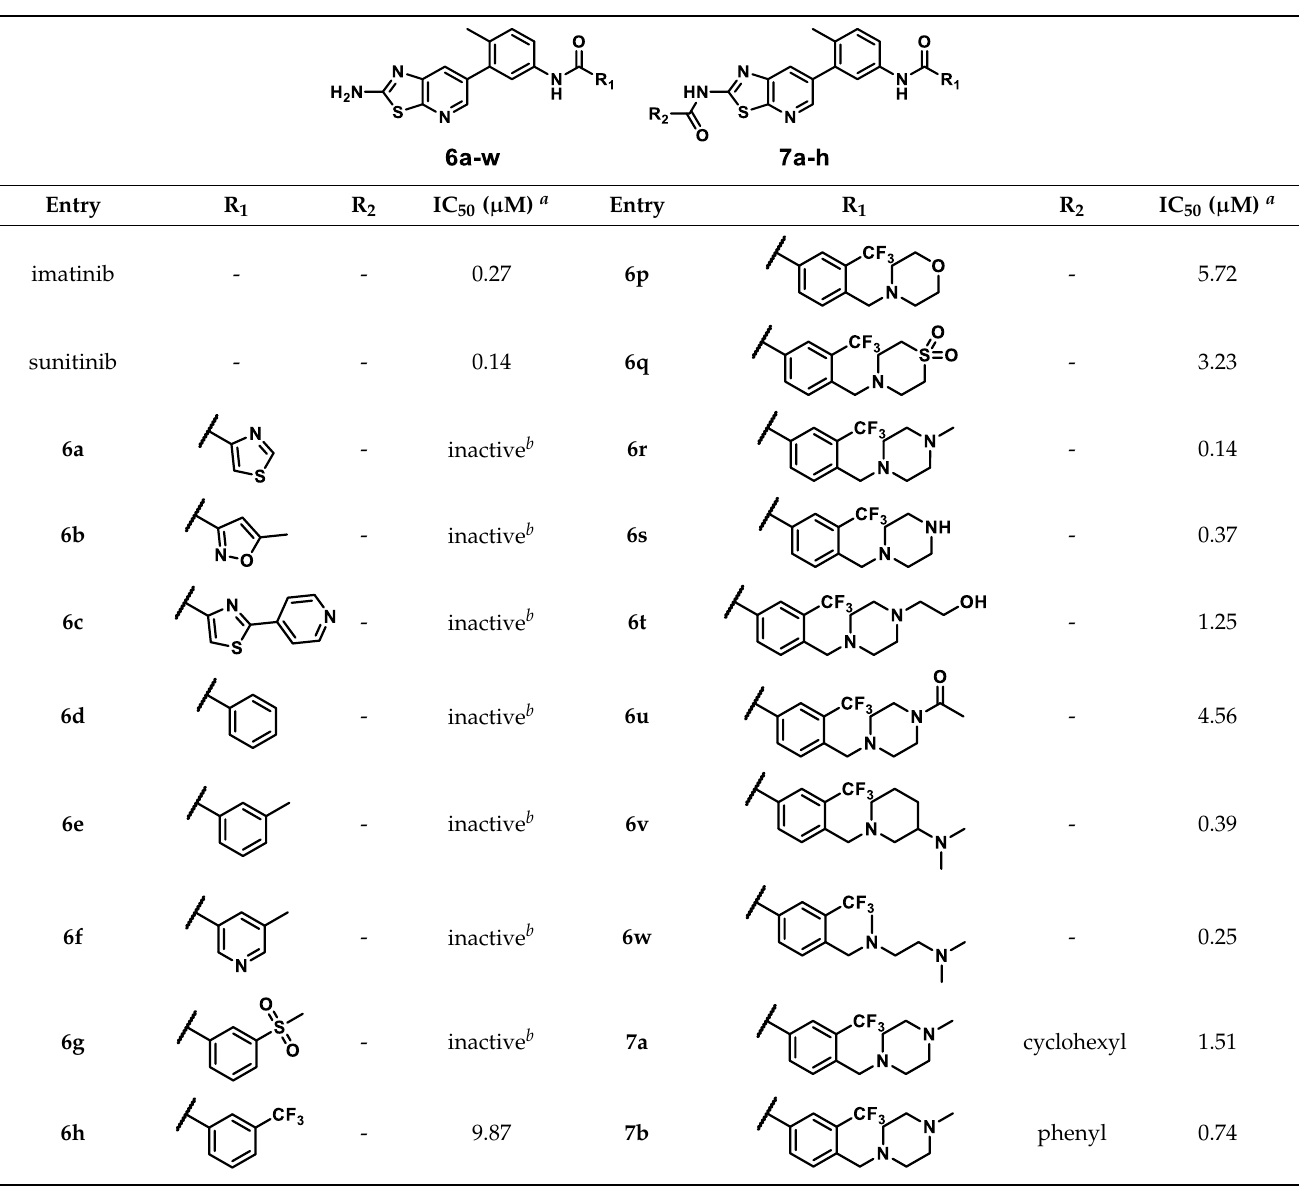
Table 1. Enzymatic inhibitory activities of thiazolo[5,4- b ]pyridine derivatives 6a–w and 7a–h against c-KIT.